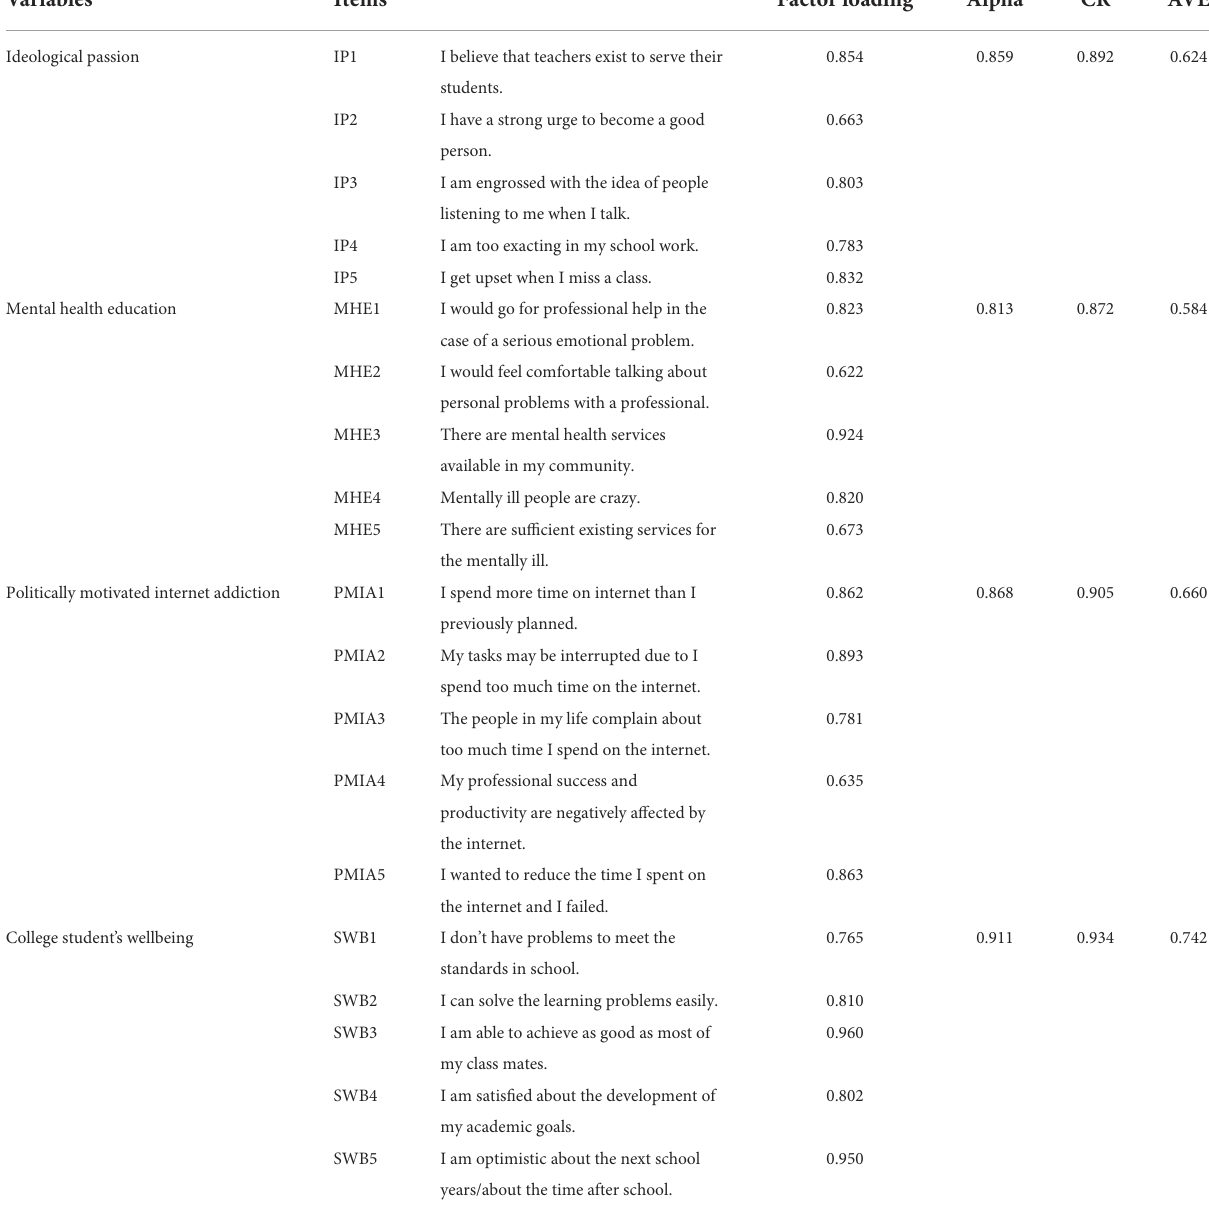
TABLE 1 Constructs, factor loadings, CR, and AVE.